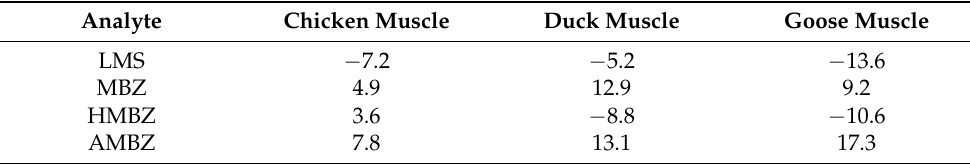
Table 4. MEs of LMS, MBZ, HMBZ and AMBZ in poultry muscle